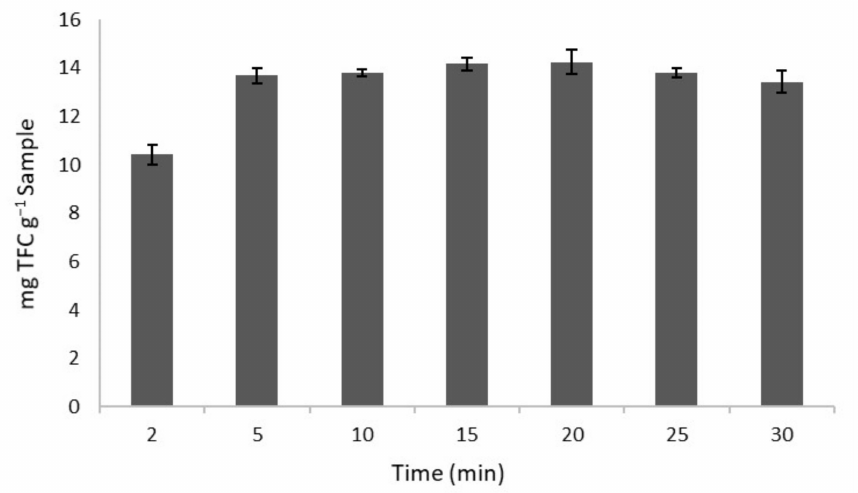
Figure 3. Total flavonoids content (TFC) obtained at different extraction times under optimal condi- tions ( n =